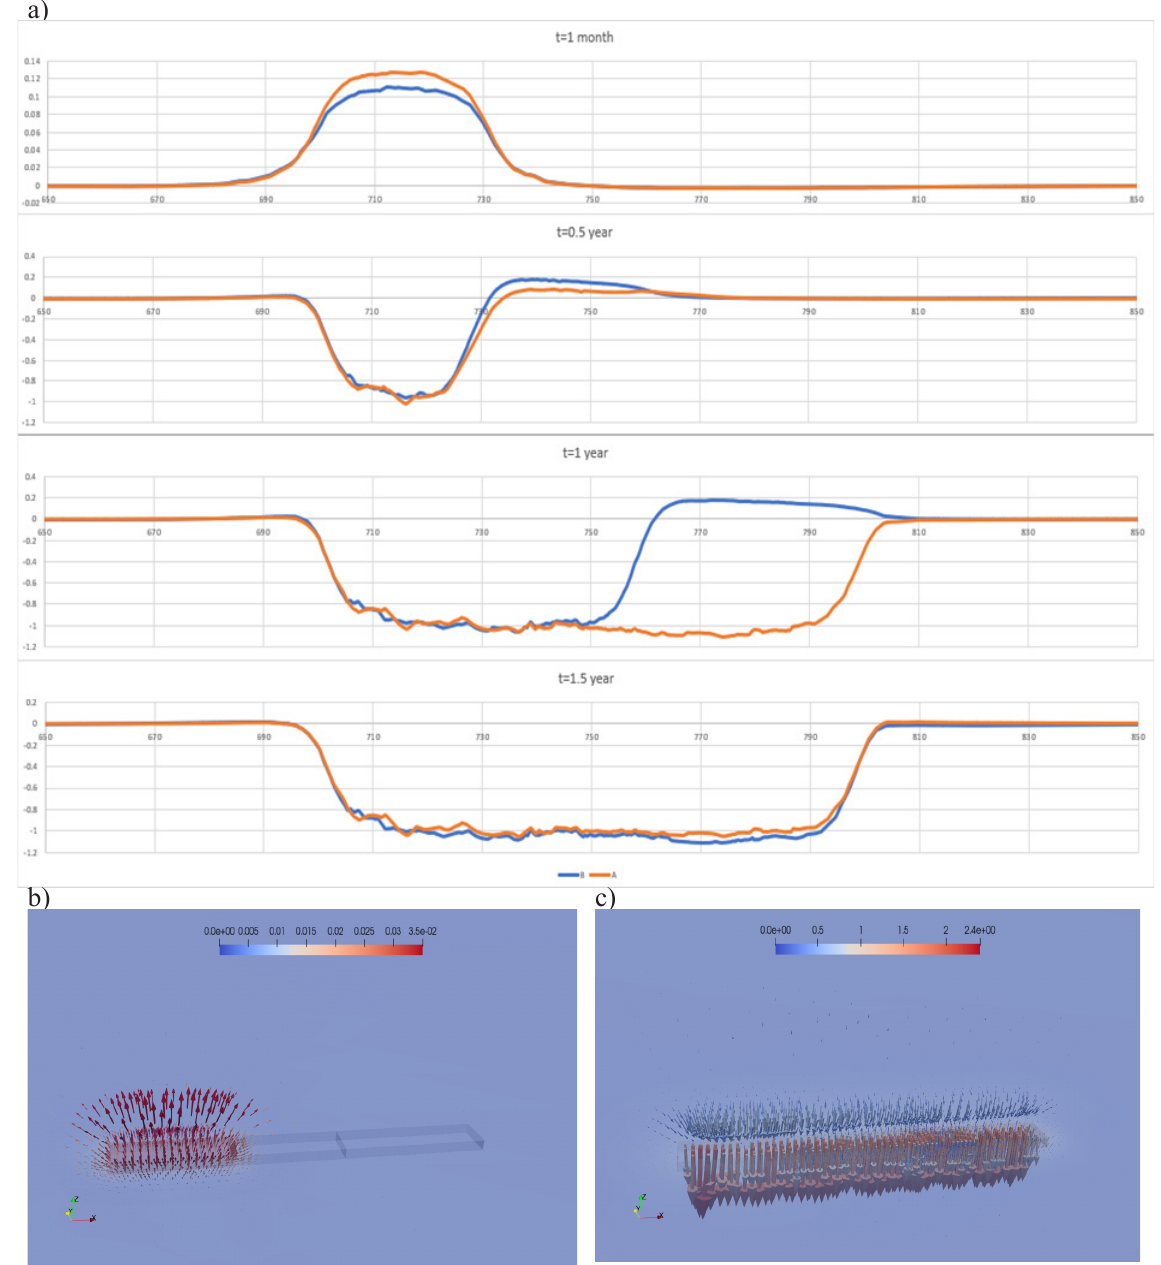
Figure 10: a) Charts of displacements (m) over time, b) 3D vector field of displacements near the generator at t = start, c) displacement vector field near the generator at time t = 2